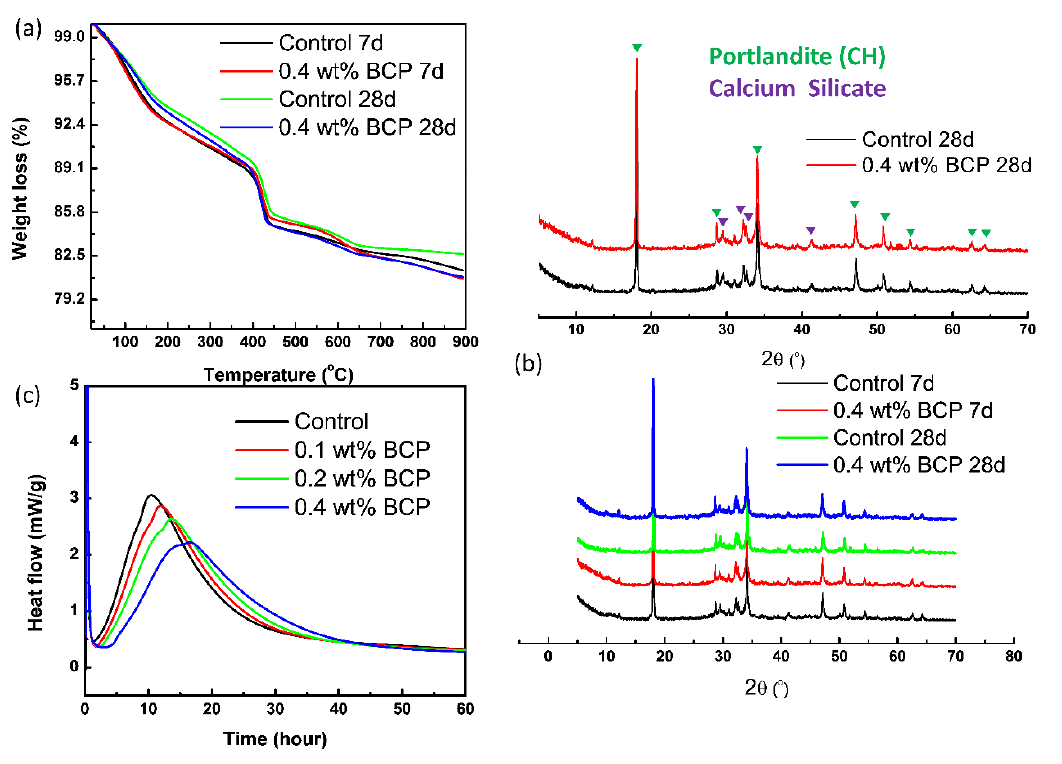
Figure 8. ( a ) TGA curves, ( b ) X-ray diffraction spectrums, and ( c ) exothermic curve of control and BCP doped cement pastes samples.